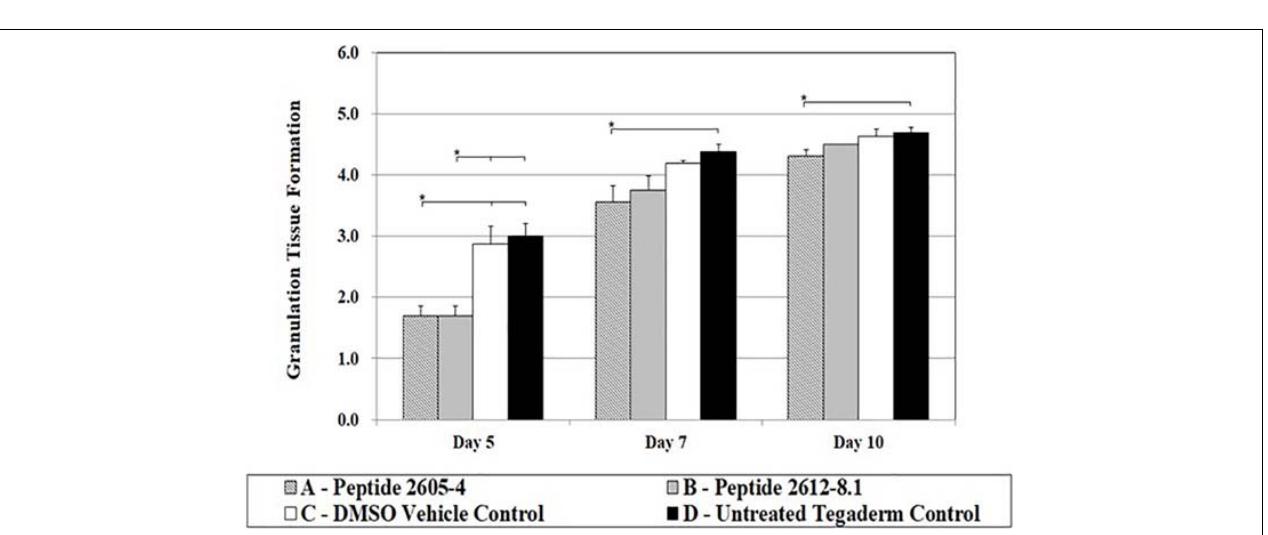
FIGURE 6 | CLP treatment affected granulation tissue formation. Comparative scores of granulating wound bed assessed on days 5, 7, and 10 from tissue section stained with H&E (1 = ≤ 5%, 2 = 6–25%, 3 = 26–50%, 4 = 51–75%, 5 = 76–100%). Statistically significant difference in granulation tissue formation was observed during progression of wound healing. Reduced levels of granulation tissue were observed on day 5 in CLP 2605-4 and CLP 2612-8.1 treated wounds compared to vehicle and untreated control (* p < 0.05). Statistically significant reduction in granulation tissue formation was also found in CLP 2605-4 treated wounds compared to vehicle and untreated control at days 7 and 10 (* p < 0.05). n = 8 per each treatment group, per time